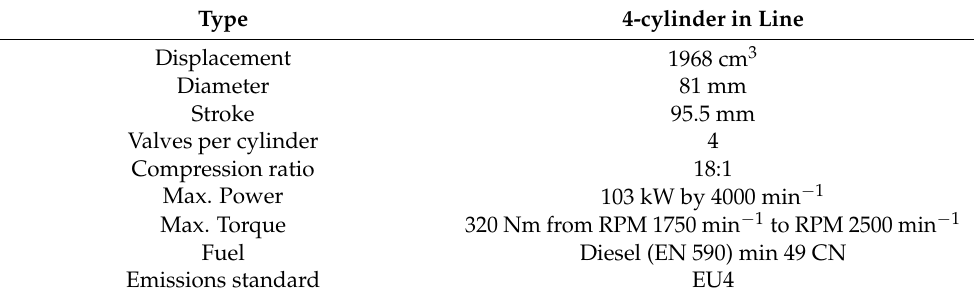
Table 1. Parameters of the investigated